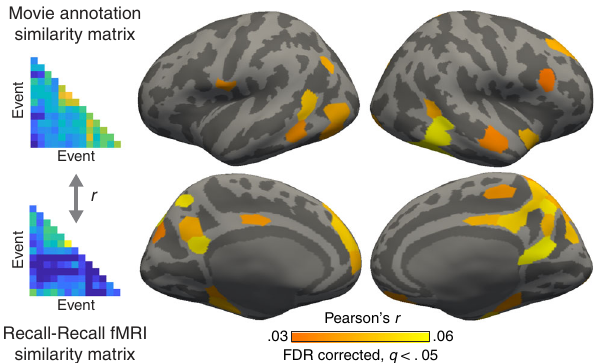
Fig. 5 Representational similarity during recall. To identify brain regions whose activation patterns during recall re fl ect the whole semantic narrative network structure, we performed a representational similarity analysis (RSA 34 ). For each cortical parcel, the representational similarity between the fMRI patterns and movie annotations was computed within each movie by correlating the cross-event intersubject pattern similarity matrix and the USE sentence embedding vector similarity matrix. The correlation coef fi cients were averaged across movies and participants. The resulting mean representational similarity was tested for statistical signi fi cance against zero using a randomization test. The whole-brain RSA map was thresholded at q < .05 (FDR-corrected across